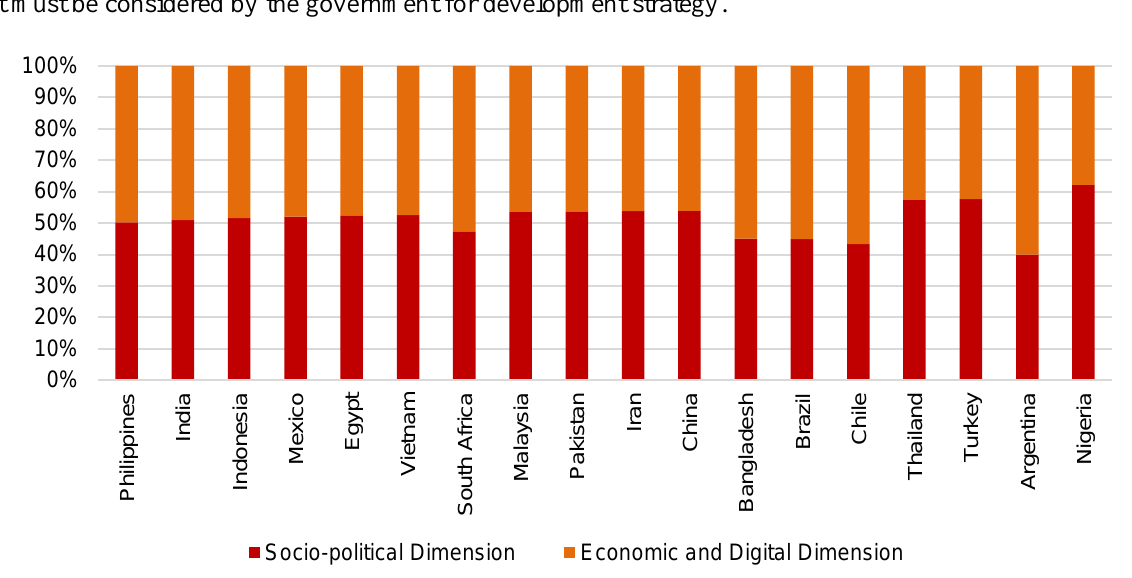
Figure 8. Balancing composite target pairs of economic, social, political and digital capability and cyber security dimensions for newly industrialized countries. Source: